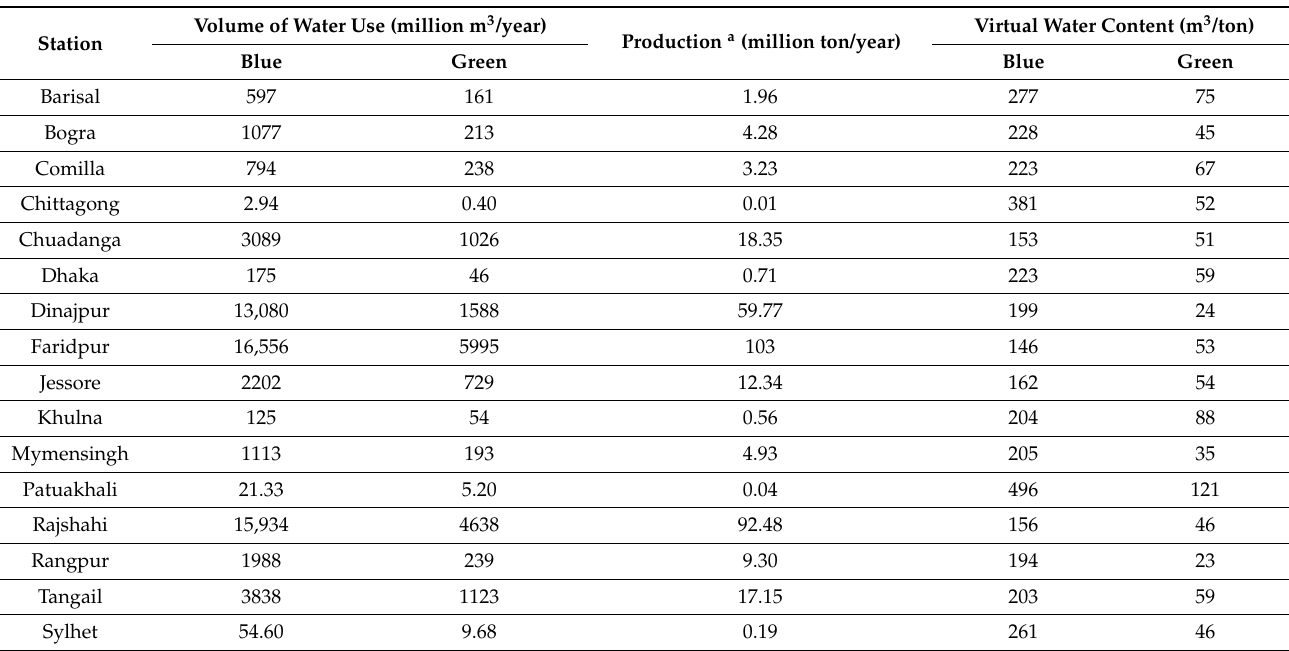
Table A4. Blue water footprint and green water footprint of wheat in Bangladesh.